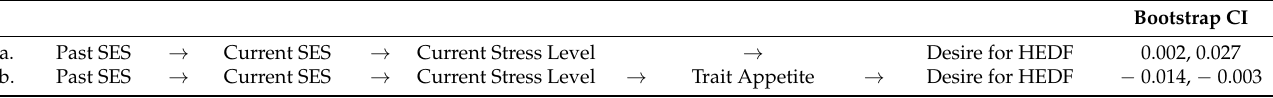
Table 4. The indirect effect of past (childhood) SES on the adult desire for high-energy-dense food.